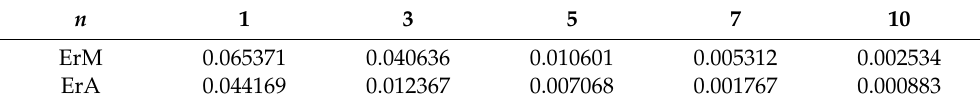
Table 1. Errors of curve